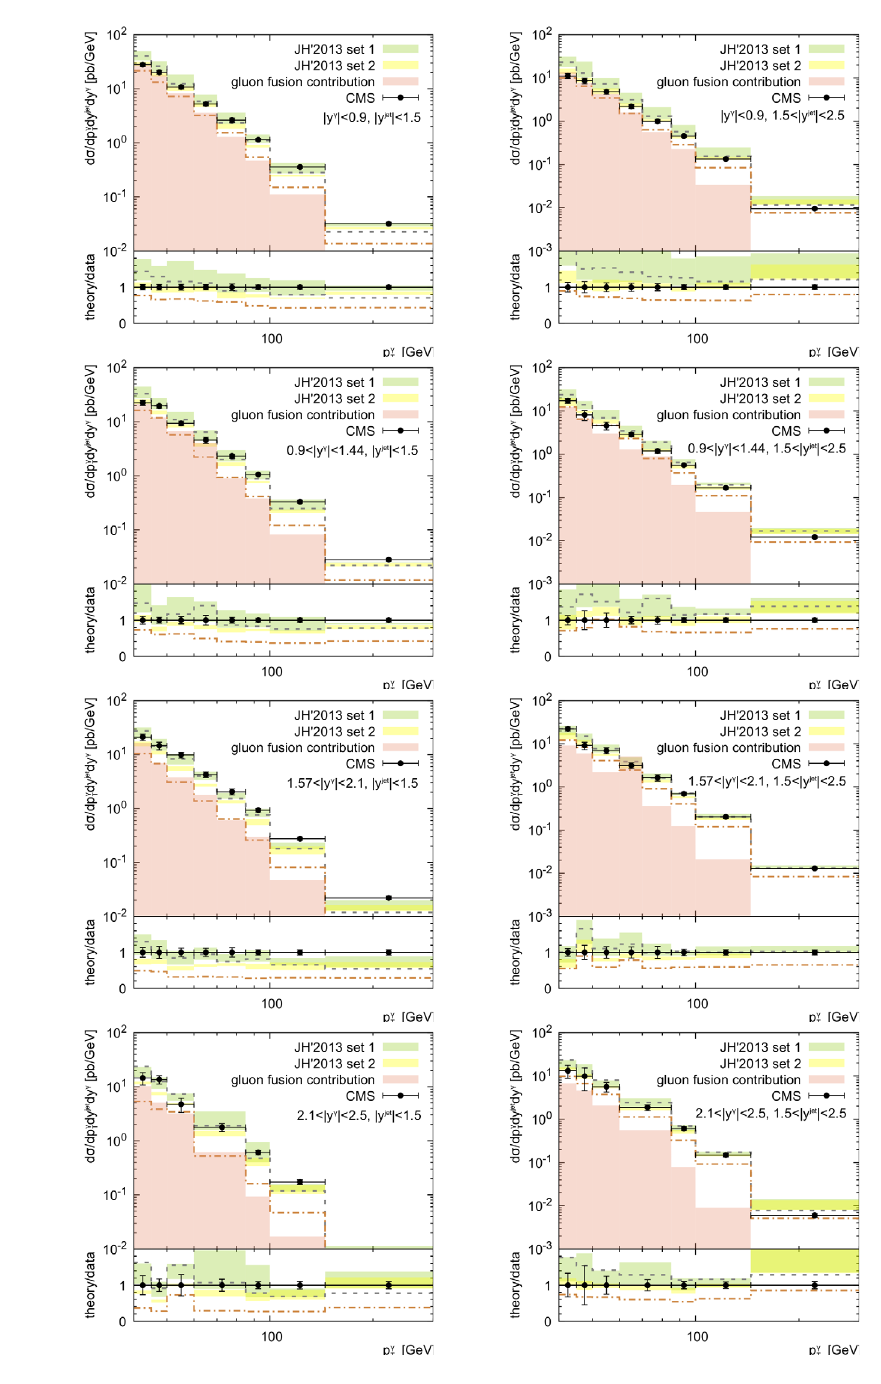
Figure 1. The di ff erential cross sections of associated γ + jet production at √ s = 7 TeV as function of the prompt photon transverse energy E γ in di ff erent regions of rapidities. The green and yellow T shaded band represent the results obtained with JH’2013 set 1 and set 2 gluon densities (with scale uncertainties). Dashed histograms corresponds to the predictions without final-state parton showers, dash-dotted histograms correspond to the results, obtained with simple approach[16]. Separately shown contribution from the o ff -shell gluon-gluon fusion subprocess (1). Everywhere the JH’2013 set 1 gluon density was used. The experimental data are from ATLAS[21].